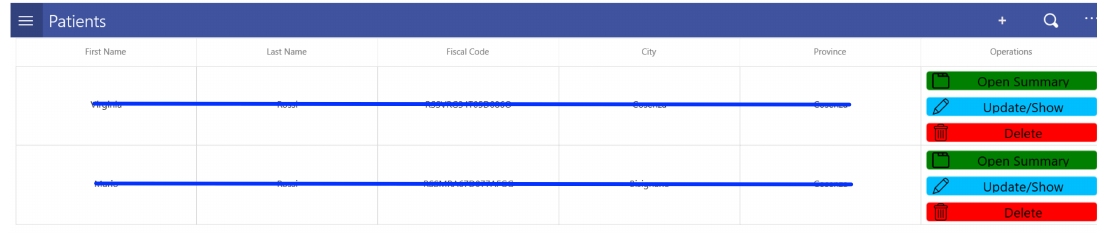
Figure 12. Patients list view.